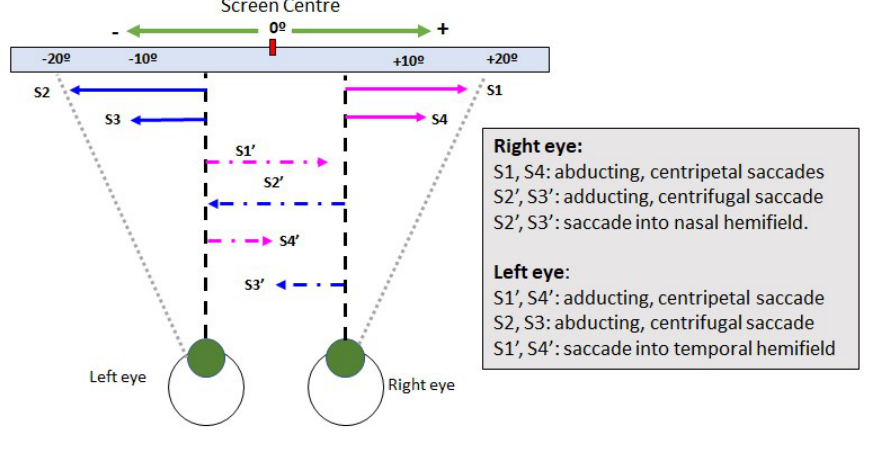
Figure 7. Binocular saccadic movements